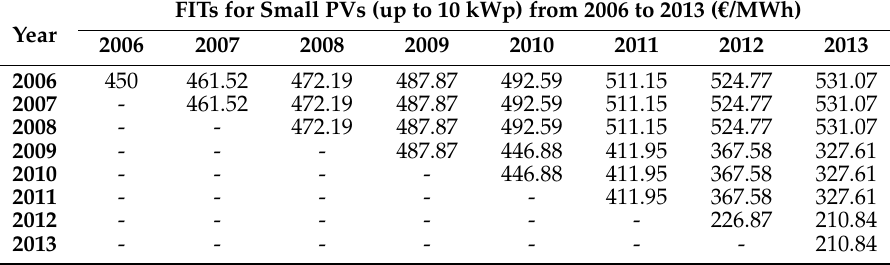
Table 2. FITs for small photovoltaics (PVs) (up to 10 kWp) from 2006 to 2013.